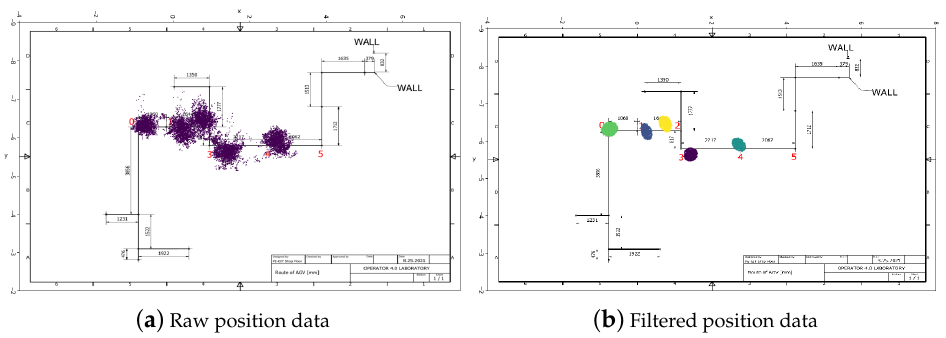
Figure 9. Subfigure ( a ) shows the predefined route and the raw position data. Due to the uncer- tainty of the measurements, the position data points are scattered and the distributions from two places in close proximity to each other overlap. Subfigure ( b ) shows the result of clustering, as well as of probability filtering, and the well-separated position clusters represent the locations of the